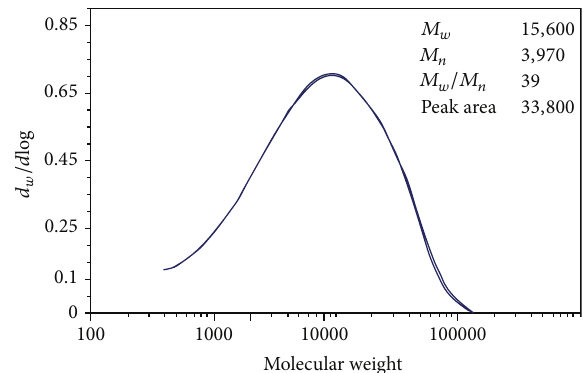
Figure 4: GPC plot showing the molecular weight distribution of